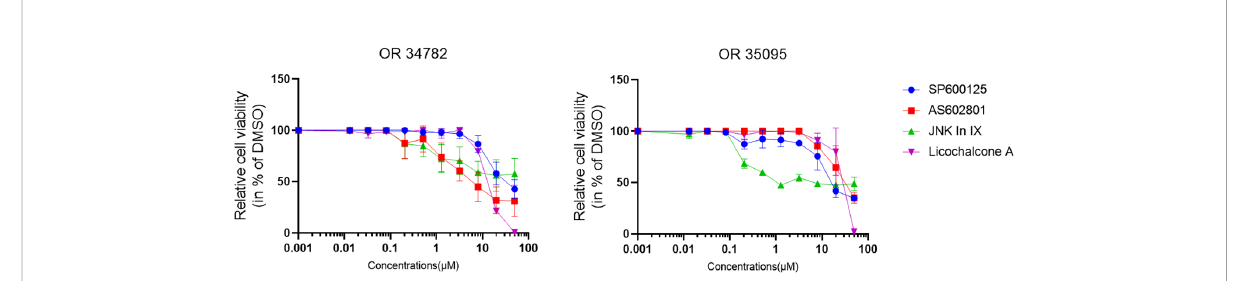
FIGURE 2 Human PC organoid treatment. Human organoids OR34782 and OR35095 were generated from PC specimen. 500 cells per well were plated in 1µl of Matrigel and cultured in 25µl Organoid growth medium. After 24 h, another 25 µl of Organoid medium was added including the indicated inhibitors. Results are shown as means of 3 (OR34782) and 2 independent replicates (OR35095).